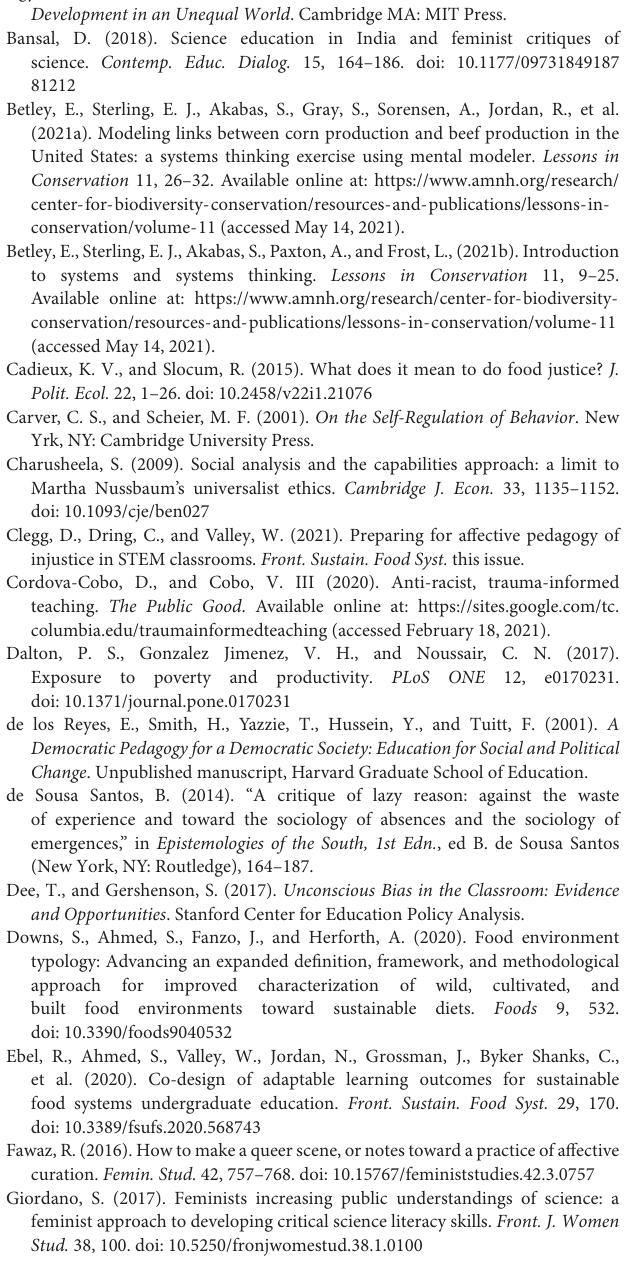
Supplementary Data Sheet 2 | Syllabus for Food Environments and Sustainable Diets (Montana State University). Supplementary Data Sheet 3 | Syllabi for Global Food Systems and Policy and Global Food and Culture (Rutgers University). Supplementary Data Sheet 4 | Syllabus for Food, Ecology, and Globalization (Columbia